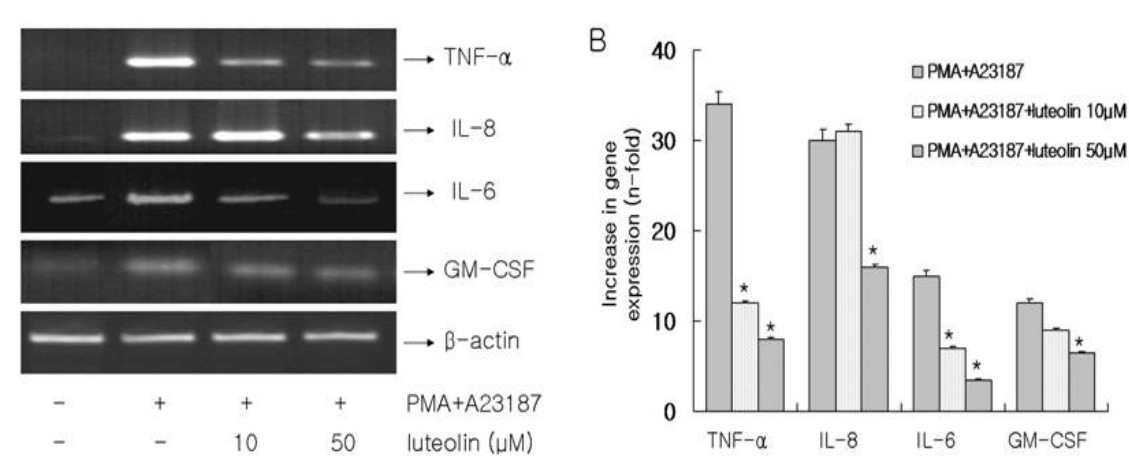
Figure 2. Effect of luteolin on gene expression of pro-inflammatory cytokines in PMA plus A23187-induced HMC-1